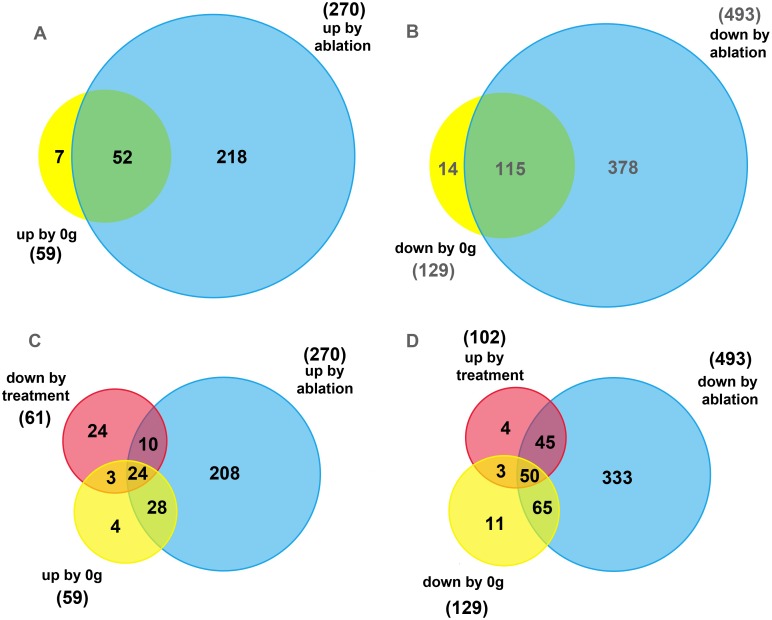
Venn diagrams illustrating the number of trabecular osteoblast genes significantly up- or downregulated by microgravity exposure (6 days) or by Pthrp ablation, and reversed by PTHrP1-36 treatment.(A) 52 genes are upregulated by both 0g (yellow) and Pthrp ablation (blue). Fold change > 2.0, p < 0.05. (B) 115 genes are downregulated by both 0g (yellow) and Pthrp ablation (blue). Fold change < 0.5, p < 0.05. (C) 24 genes are upregulated by both 0g (yellow) and Pthrp ablation (blue), and are also downregulated (central intersect) by PTHrP1-36 treatment (red). Fold change < 0.65, p < 0.05. (D) 50 genes are downregulated by both 0g (yellow) and Pthrp ablation (blue), and upregulated (central intersect) by PTHrP1-36 treatment (red). Fold change >1.5, p < 0.05.